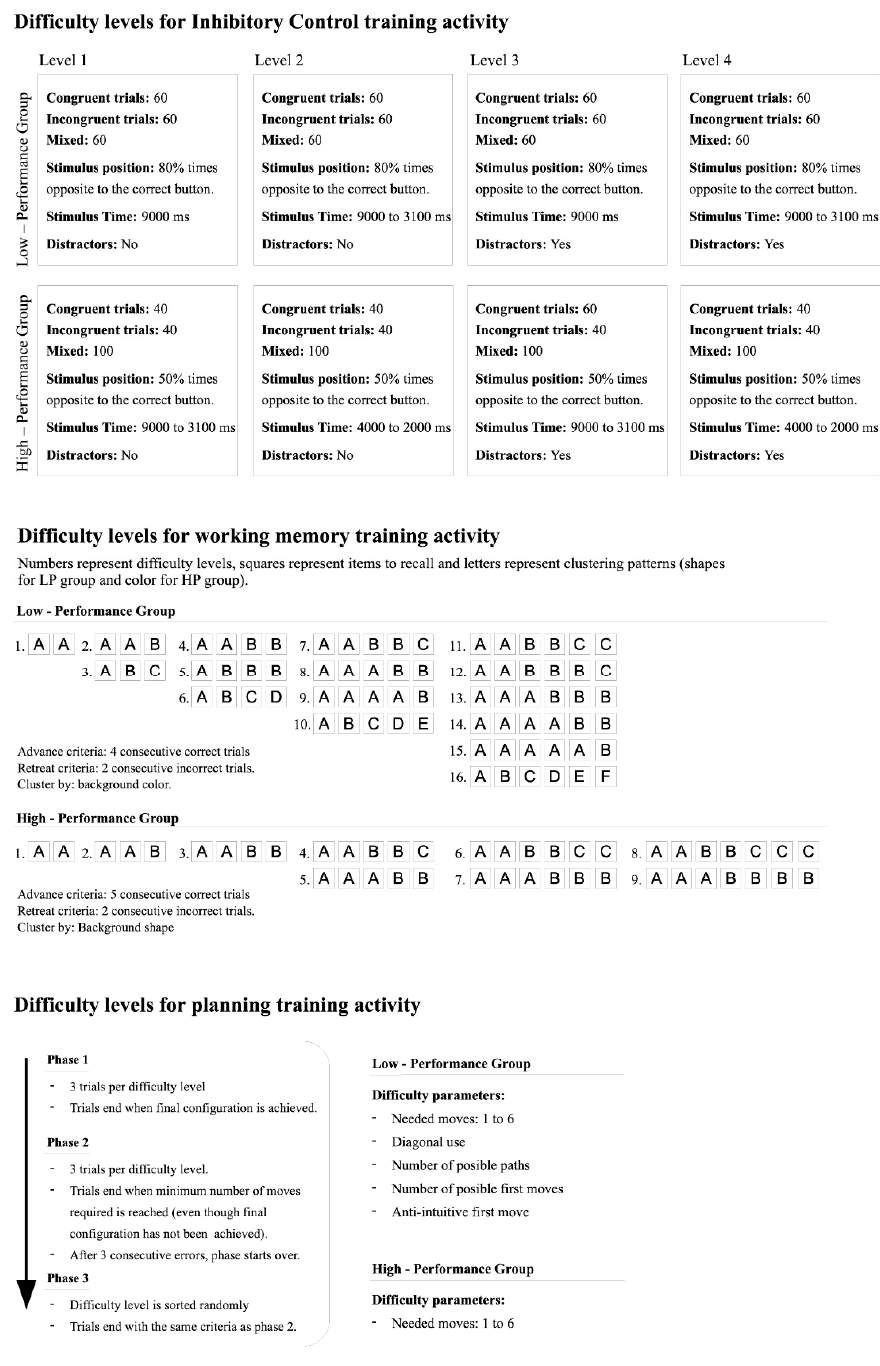
Figure 2. Training schemes and difficulty levels for each training activity and performance group.